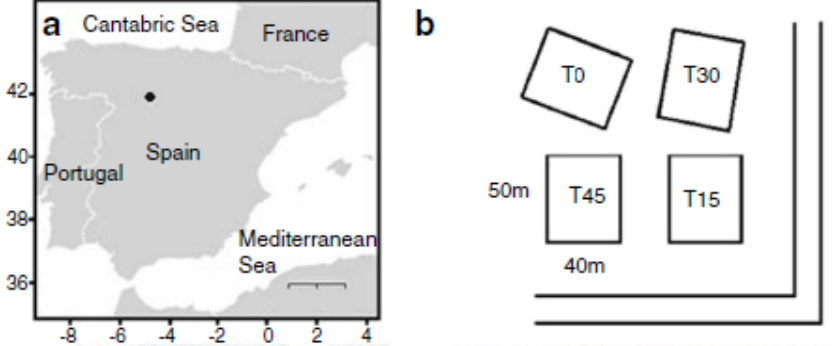
Figure 1. Location ( a ) and design ( b ) of the experimental plot in Spain. T0-Control; T15-15% removal of the basal area; T30-30% removal of the basal area; T45—45% removal of the basal area. The basal area reduction was performed as a thinning from